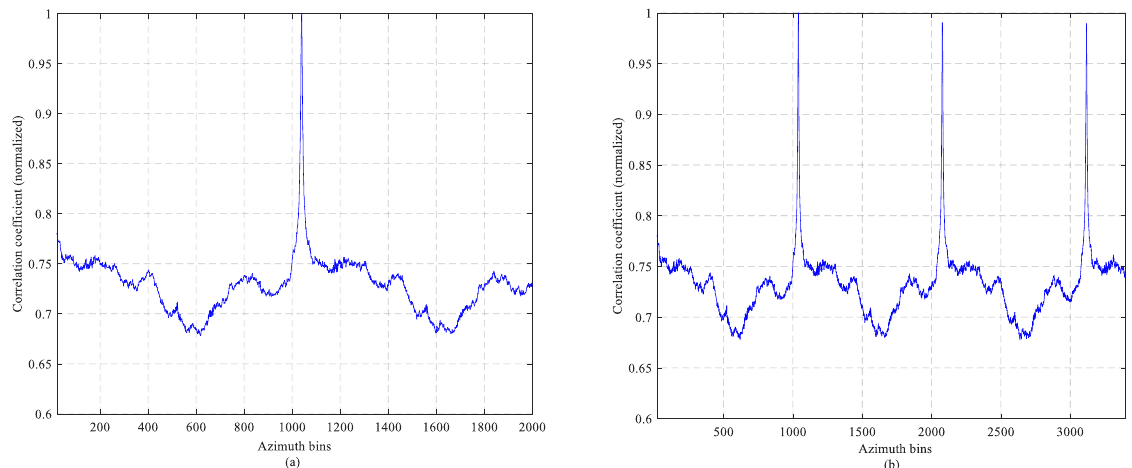
parameters are that the target rotation angular velocity is 6.05 rad/s, and the PRF is 1000 Hz, so the theoretical rotation period is 1038.54 PRT. Through the method proposed, the rotation period is best estimated. When the target echo contains multiple rotation periods, the sliding cross-correlation coefficient of the echo using the method proposed in this paper is shown in Figure 11b. It can be seen that there are three peaks at 1040, 2078, and 3117, which are consistent with the simulation parameters, verifying the proposed method.